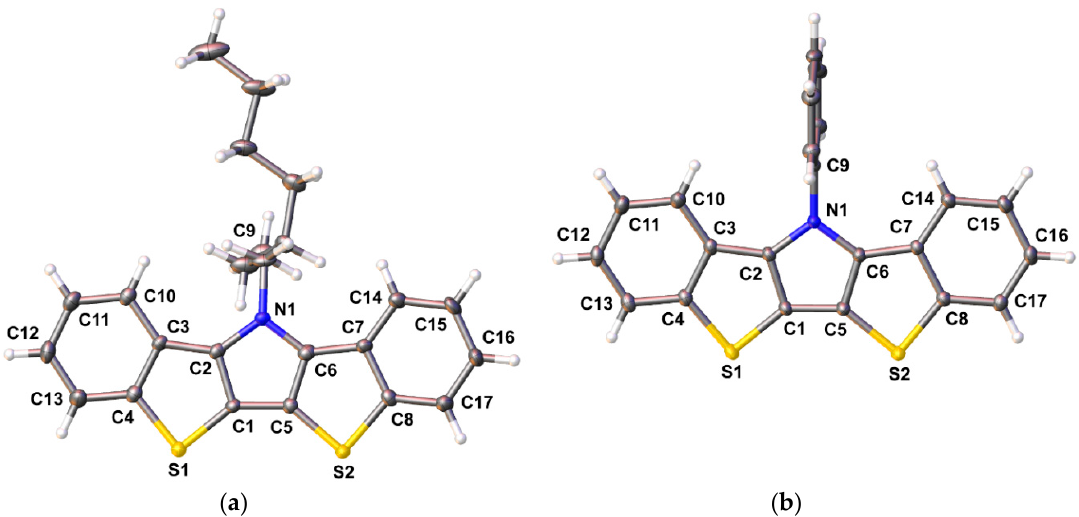
Figure 4. Ellipsoid plots of bis[1]benzothieno[3,2 ‐ b :2 ′ ,3 ′‐ d ]pyrroles 1e ( a ) and 1i ( b ) at the 50% probability level.